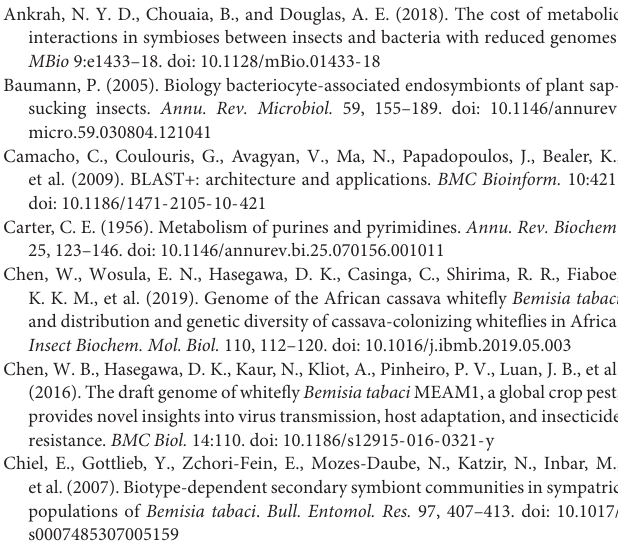
tabaci :astatementofspeciesstatus. Annu.Rev.Entomol. 56,1–19.doi:10.1146/